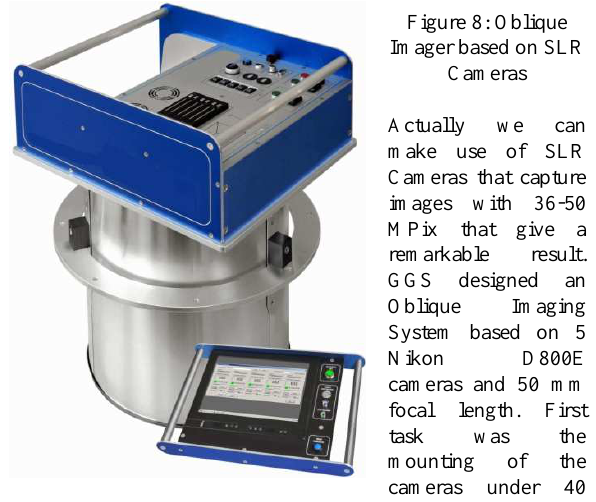
Figure 8: Oblique